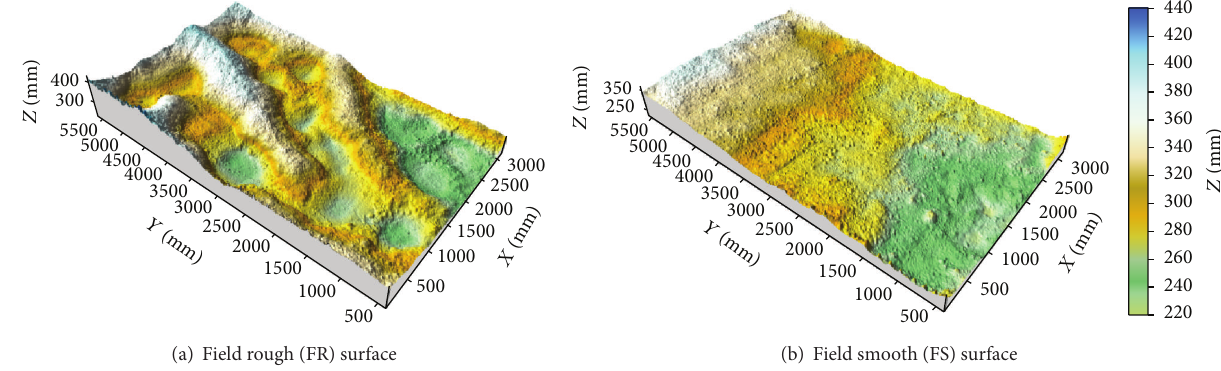
Figure 2: Rough and smooth field plots used for field overland flow